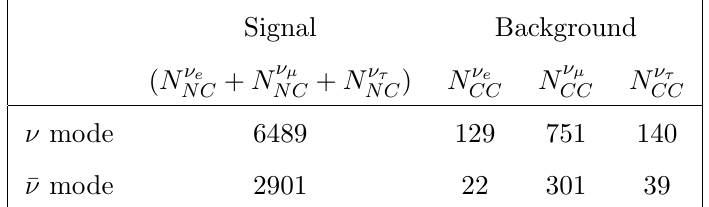
Table 1 . Expected total number of events with a (reconstructed) visible energy between 0.5 and 8 GeV at the DUNE far detector. The number of events is shown for the signal and background contributions separately. This corresponds to 7 yrs of data taking (equally split between neutrino and antineutrino running modes) with a 40 kton detector and 1.07 MW beam power, yielding a total of 300 kt (cid:1) MW (cid:1) yr. In all cases, signal and background rejection e(cid:14)ciencies have already been accounted for. In the case of N (cid:23) (cid:28) , the number of events already includes the branching ratio for CC hadronic (cid:28) decays. Usual oscillations (in the three-family scenario) have been considered in the computation of the backgrounds, setting (cid:18) 23 = 42 (cid:14) and the rest of the oscillation parameters in agreement with their current best-(cid:12)t